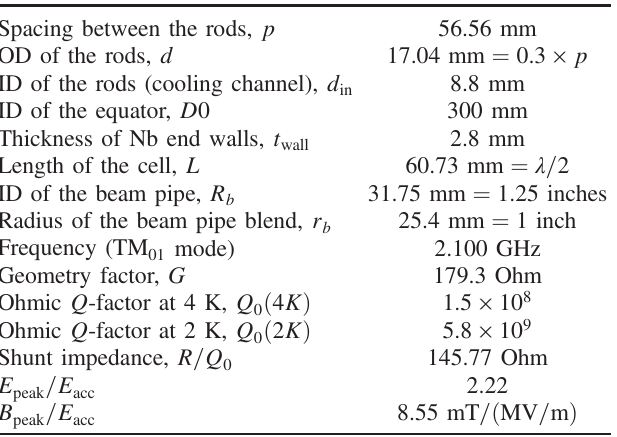
TABLE I. The dimensions and accelerator characteristics of the 2.1 GHz SRF PBG accelerator cavity with round rods reported in